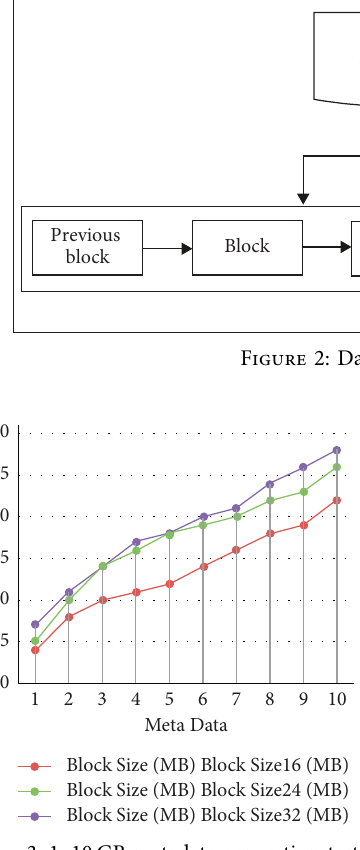
Figure 4: Generating test for attestation metadata within